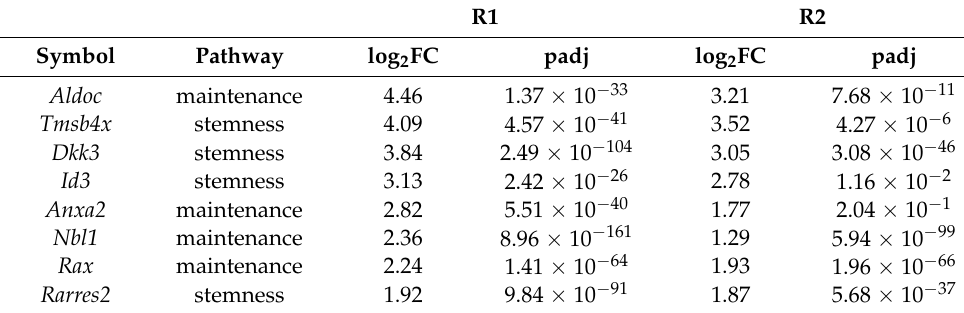
Table 5. Differential expression of selected SP cell genes in cluster